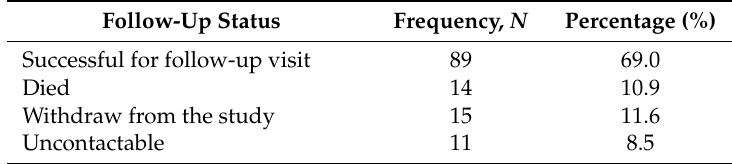
Table 2. Frequency and percentage of subjects for follow-up and the dropouts in the